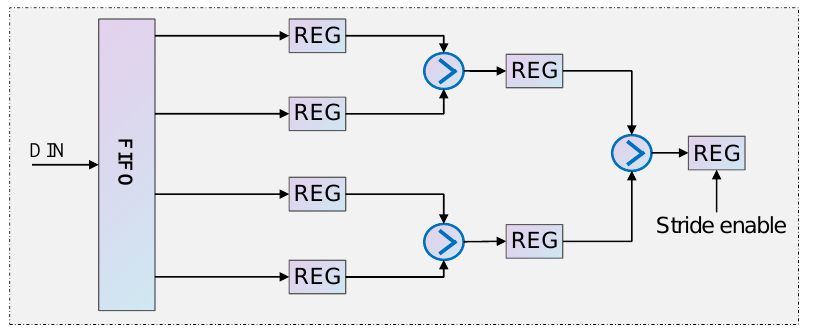
Figure 16. Hardware architecture of the max-pooling layer using a kernel size of 2 ×